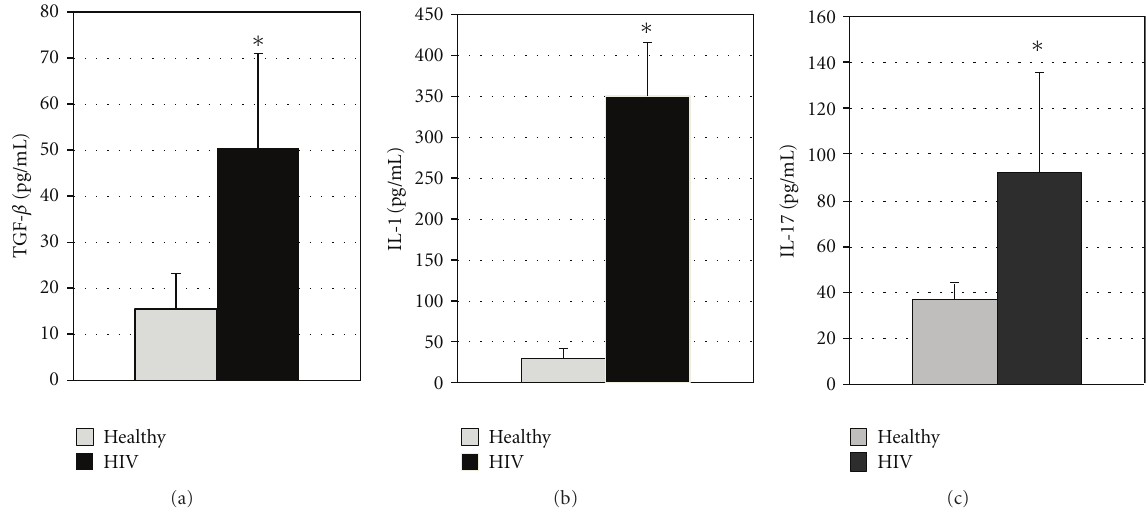
Figure 2: (a) Assay of TGF- β in plasma from HIV-infected and healthy subjects . Plasma samples separated from blood of healthy volunteers and HIV-infected individuals were used for measurement of TGF- β . Levels of TGF- β in the plasma samples were determined by ELISA using assay kits procured from eBioscience. Results in Figure 2 are averages of data collected from eight healthy subjects and twelve individuals with HIV infection. Results show elevated TGF- β in HIV-infected subjects ( ∗ P ≤ 0 . 05). (b) Assay of IL-1 in plasma from HIV-infected and healthy subjects . Plasma samples separated from blood of healthy volunteers and HIV-infected individuals were used for measurement of IL-1. Levels of IL-1 in the plasma samples were determined by ELISA using assay kits procured from eBioscience. Results in (b) are averages of data collected from eight healthy subjects and twelve individuals with HIV infection. Results show elevated IL-1 in HIV-infected subjects ( ∗ P ≤ 0 . 05). (c) Assay of IL-17 in plasma from HIV-infected and healthy subjects. Plasma samples separated from blood of healthy volunteers and HIV-infected individuals were used for measurement of IL-17. Levels of IL-17 in the plasma samples were determined by ELISA using assay kits procured from eBioscience. Results in (c) are averages of data collected from eight healthy subjects and eight individuals with HIV infection. Results show elevated IL-17 in HIV-infected subjects ( ∗ P ≤ 0 .